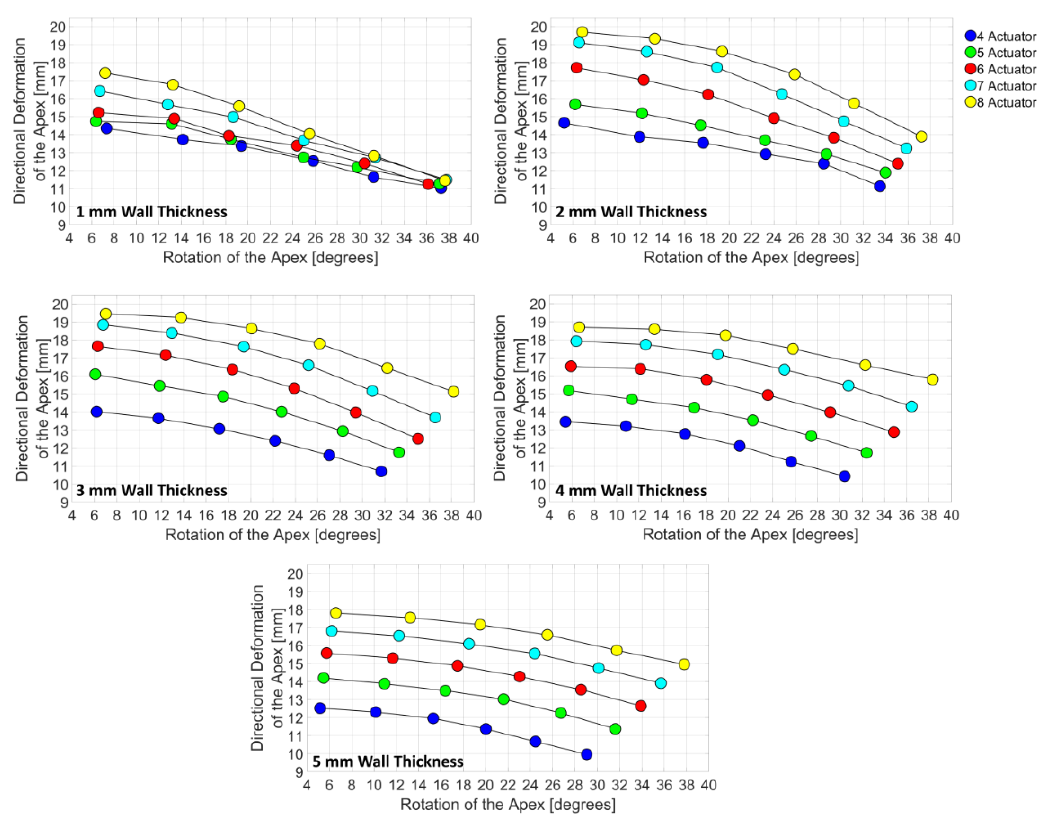
Figure 10. Effect of the number of actuators on different wall thickness in the design domain. Actuator orientation is changing from 15 degrees to 90 degrees, from left to right in the figures.